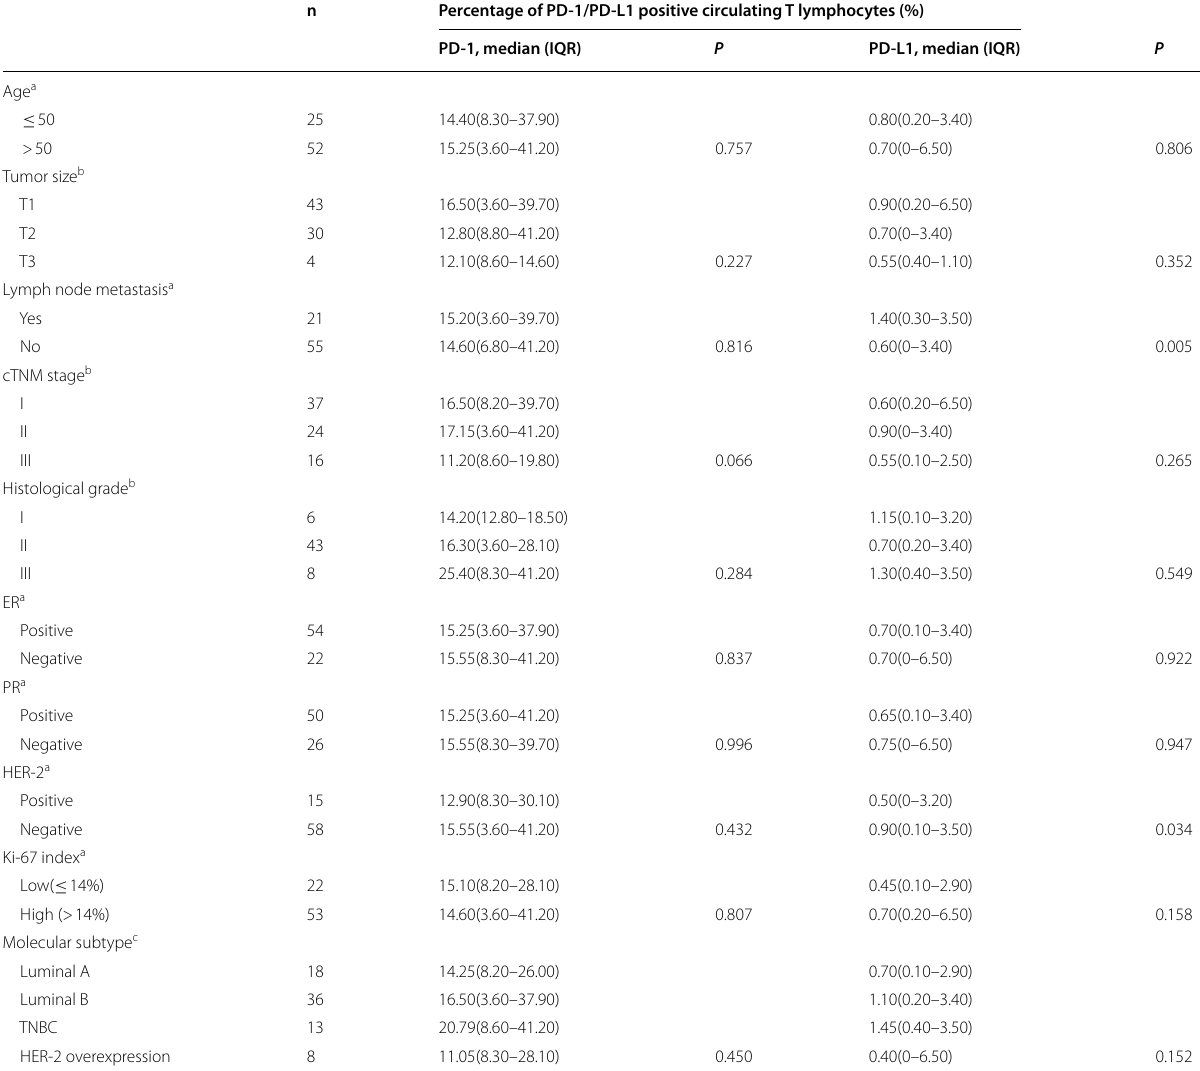
Table 1 The relationship between the percentage of PD-1/PD-L1 positive circulating T lymphocytes and clinicopathological